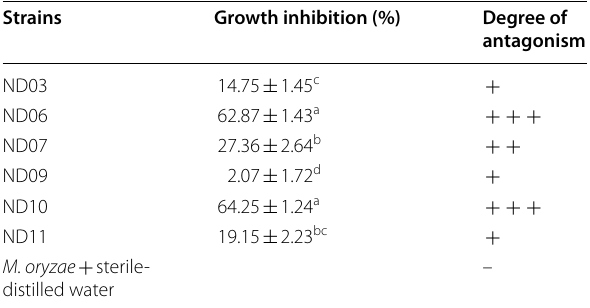
Table 3 In vitro inhibition of growth of Magnaporthe oryzae by single bacterial antagonists on TSA medium